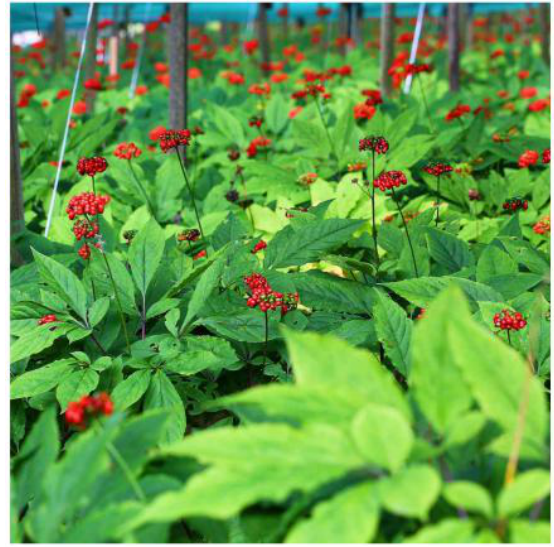
Figure 6. Panax ginseng C.A. Meyer